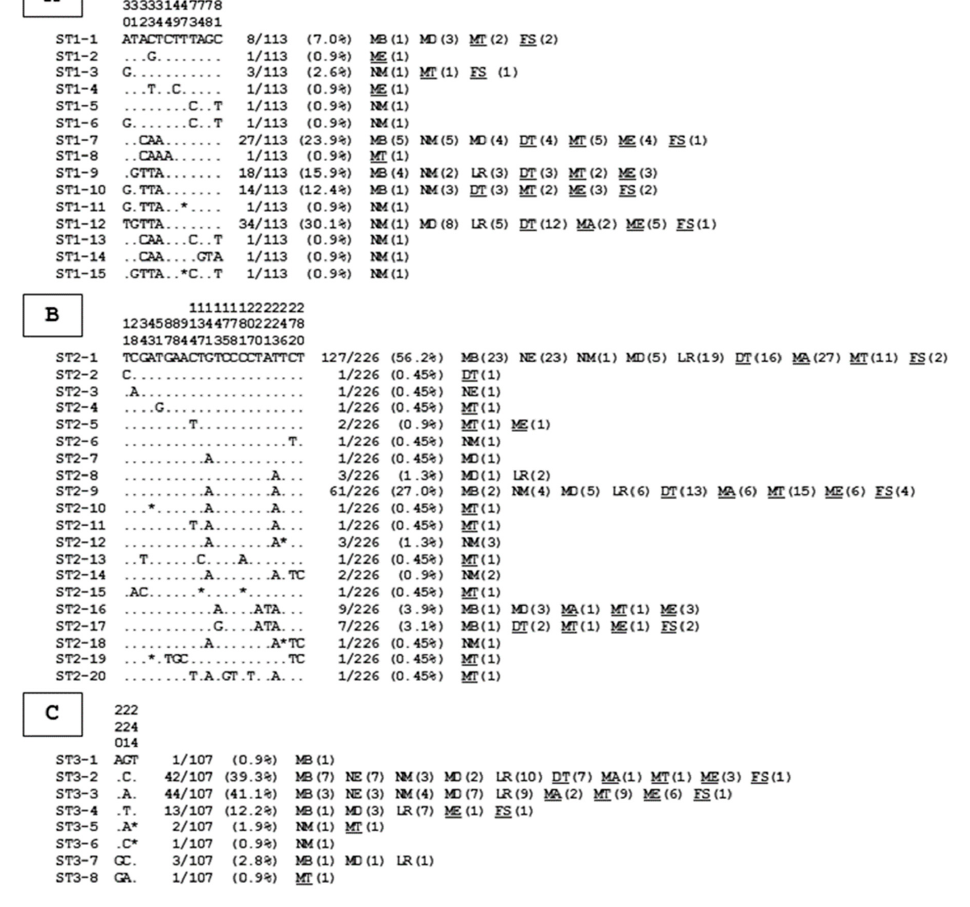
Figure 2. Alignment of partial SSU rDNA gene sequences from Blastocystis sp. ST1 ( A ), ST2 ( B ), and ST3 ( C ) isolates. Only the variable positions identified in the compared domain of the gene for these STs are shown in this alignment. The positions of variable nucleotides with respect to the reference sequences (genotypes ST1-1, ST2-1, and ST3-1) are indicated above the alignment (vertical numbering). Nucleotides identical to those of the reference sequences are represented by dashes and gaps are represented by asterisks. All the genotypes identified for each ST are indicated on the left of the alignment. On the right of the alignment is reported the total number and percentage of isolates identified in our study for each genotype followed by their repartition per village (number of isolates in parentheses). Abbreviations: MB, Mbakhana; MD, Maka Diama; NM, Ndiol Maure; LR, Lampsar; NE, Ndiawdoune; MT, Malla Tack; FS, Foss; ME, Mbane; DT, Diokhor Tack; MA, Malla. The abbreviations of the villages located in the area of Lake Guiers are underlined, which is not the case of those located in the area of